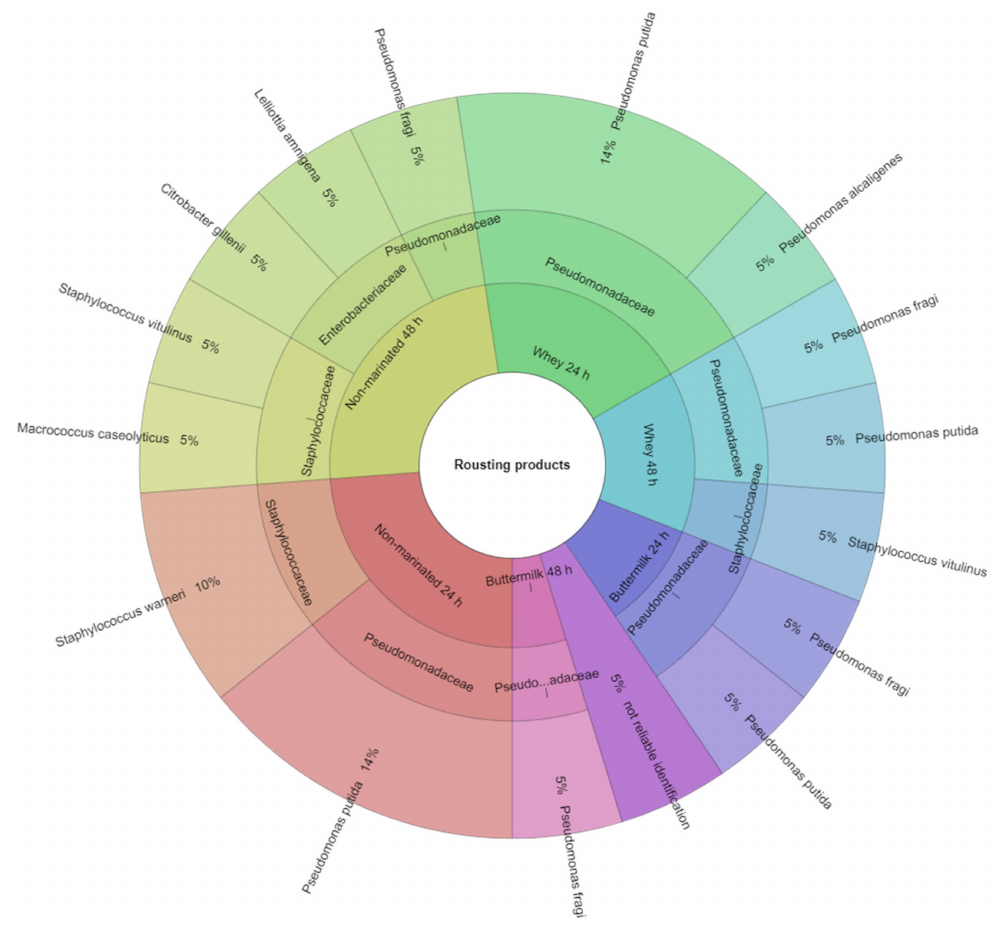
Figure 2. Identified species and family of bacteria isolated in the roast products. Table 3. E ff ect of marinating on texture parameters of roast